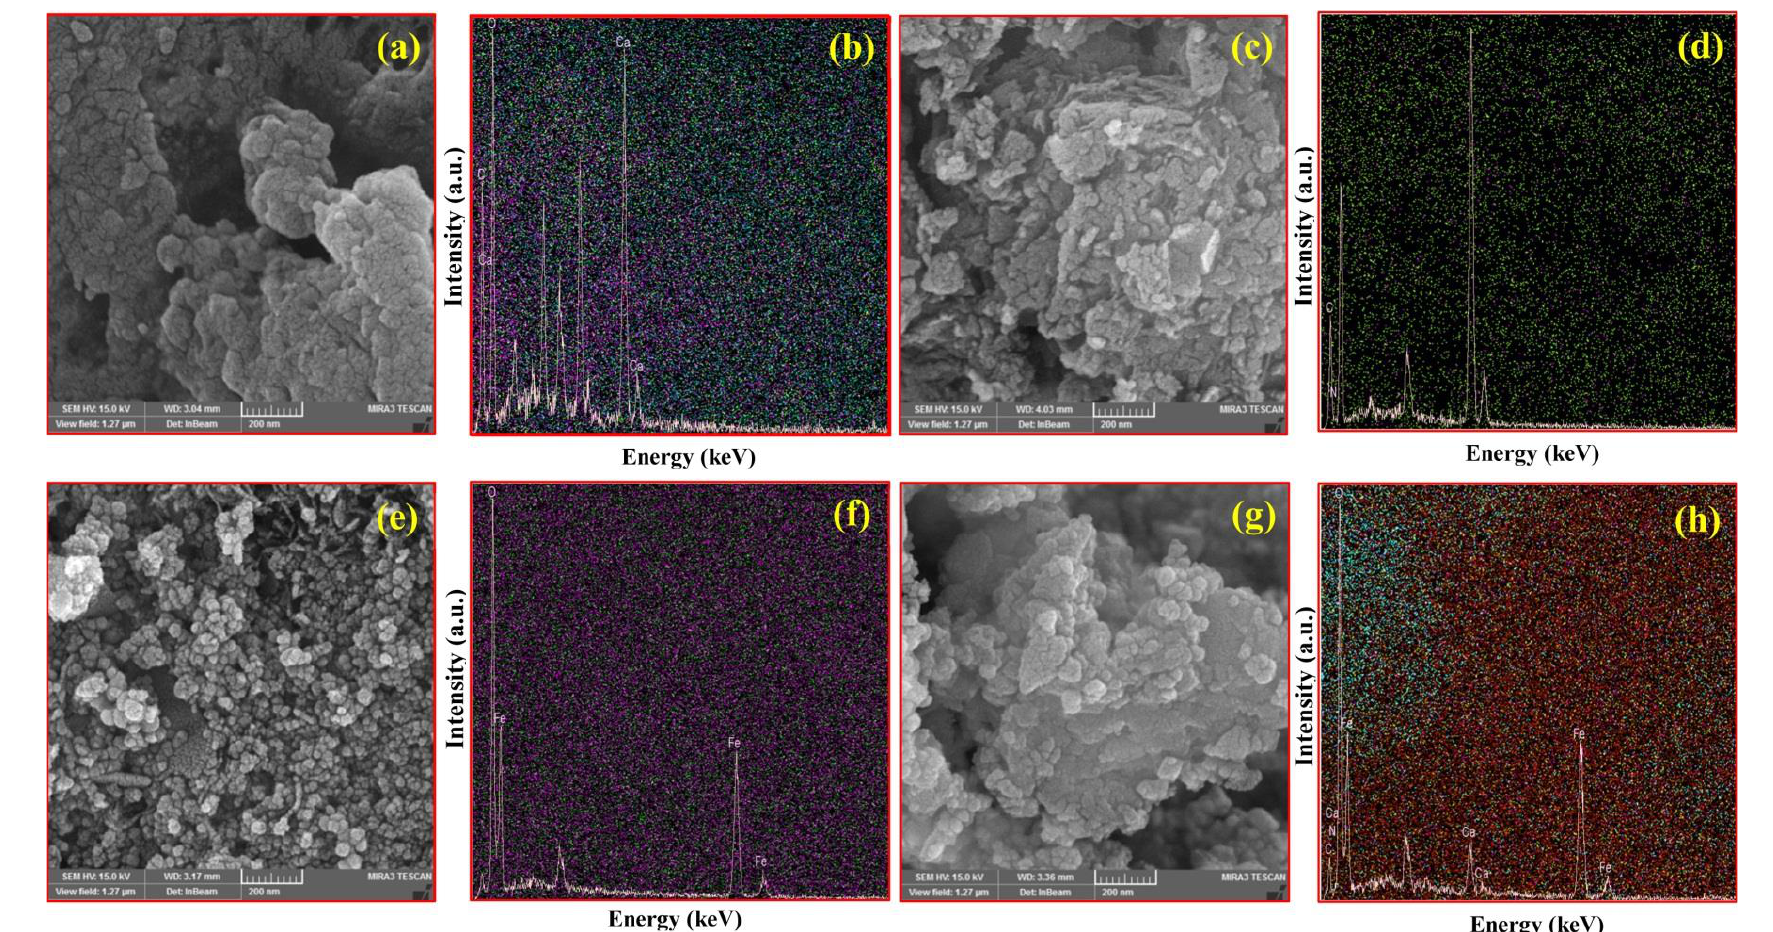
Figure 1. SEM images of CA ( a ) with EDX-Map ( b ), CM ( c ) with EDX-Map ( d ), MNPs ( e ) with EDX-Map ( f ), and CM/MNPs/CA ( g ) with EDX-Map ( h ).